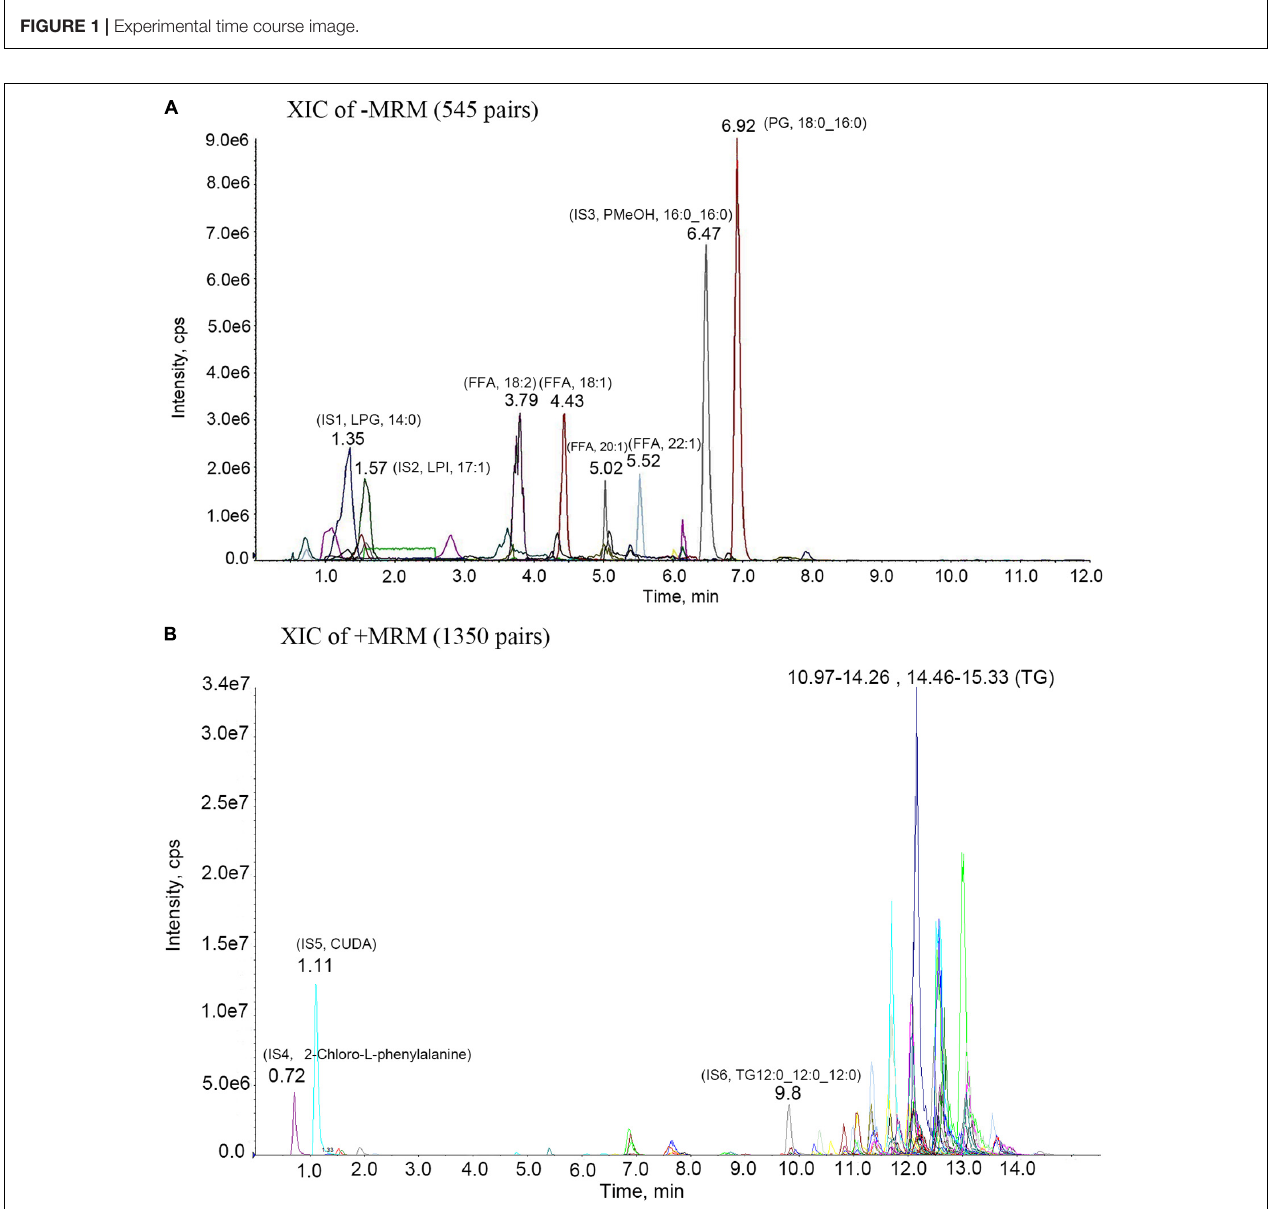
FIGURE 2 | MRM metabolite assay multi-peak chart. IS1-IS6 are all internal standard; (A) -MRM metabolite assay multi-peak chart. 3.79- (FFA, 18:2)- Linoleic acid; 4.43- (FFA, 18:1)- Oleic acid; 5.02- (FFA, 20:1)- Eicosenoic Acid; 5.52- (FFA, 22:1)- Erucic acid; 6.92- (PG, 18:0_16:0)- Phosphatidyl Glycerols (18:0_16:0); (B) + MRM metabolite assay multi-peak chart. 11.33- (TG,16:0_18:2_18:2)- Triglyceride (16:0_18:2_18:2); 11.7- (TG,18:2_18:2_20:1)- Triglyceride (18:2_18:2_20:1); 12.15- (TG, 18:2_18:2_22:1)- Triglyceride (18:2_18:2_22:1); 13- (TG,18:1_18:1_22:1)- Triglyceride (18:1_18:1_22:1).